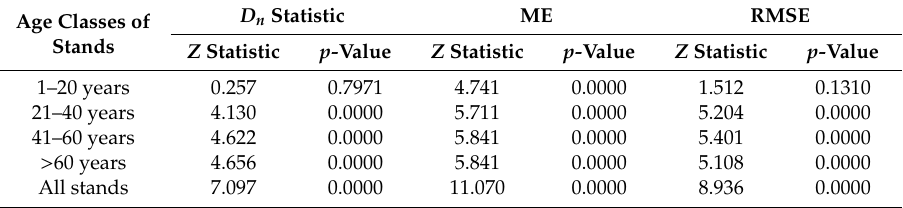
Table 4. Results of the Wilcoxon signed-rank test for comparison of goodness-of-fit statistics for the Weibull and percentile diameter distribution